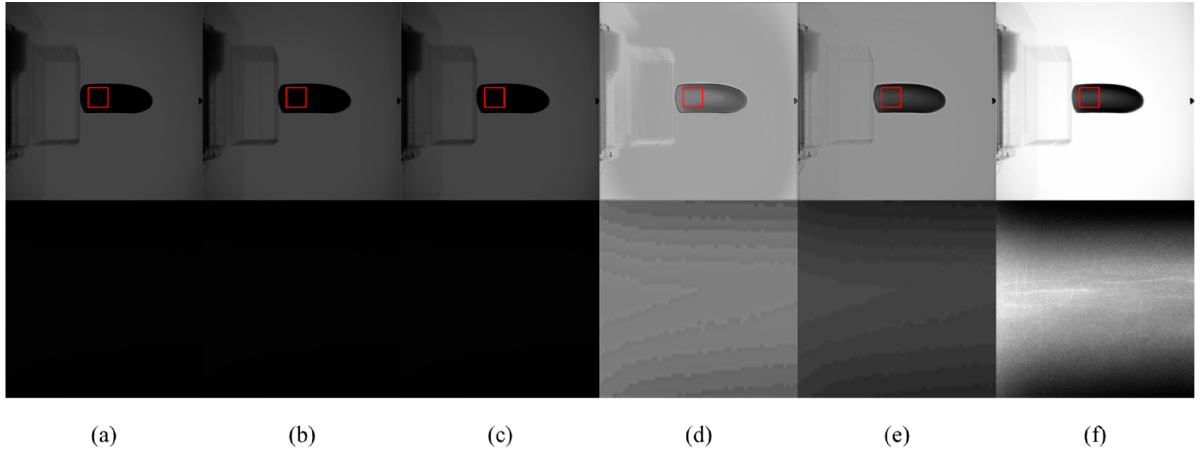
Figure 15. The contrast enhancement results of different methods. Top: raw image and the enhance- ment results; bottom: zoomed-in views on the highlighted area. ( a ) The raw images; ( b ) CLAHE; ( c ) LCM-CLAHE; ( d ) Retinex-Net; ( e ) Zero-DCE; and ( f ) our method.